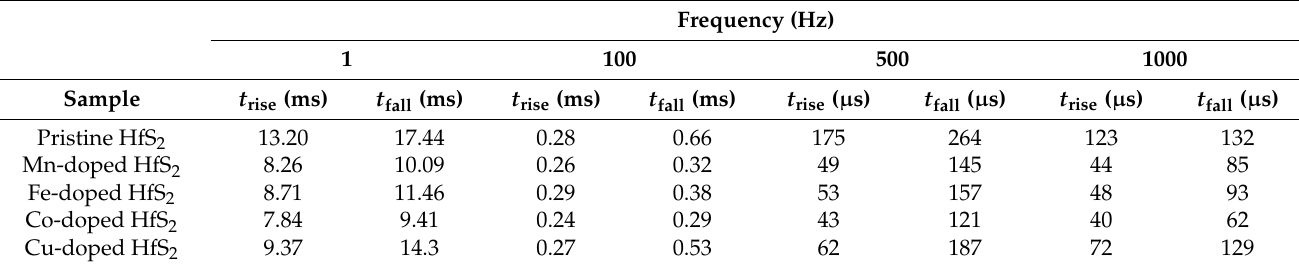
Table 4. Rise time t rise and fall time t fall of the pristine, Mn-, Fe-, Co-, and Cu-doped HfS 2 crystals under different illumination frequencies.